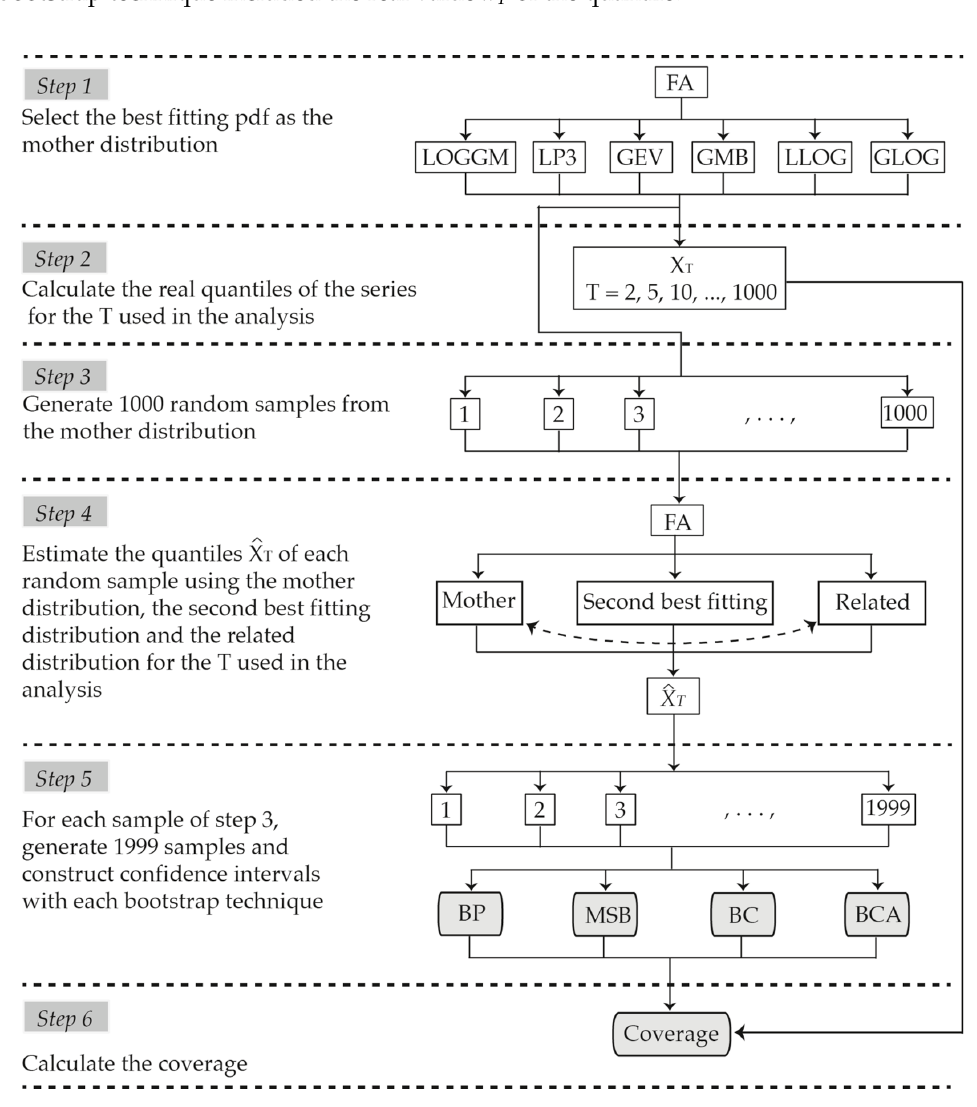
Figure 2. Methodological process for obtaining the coverage of the confidence intervals.